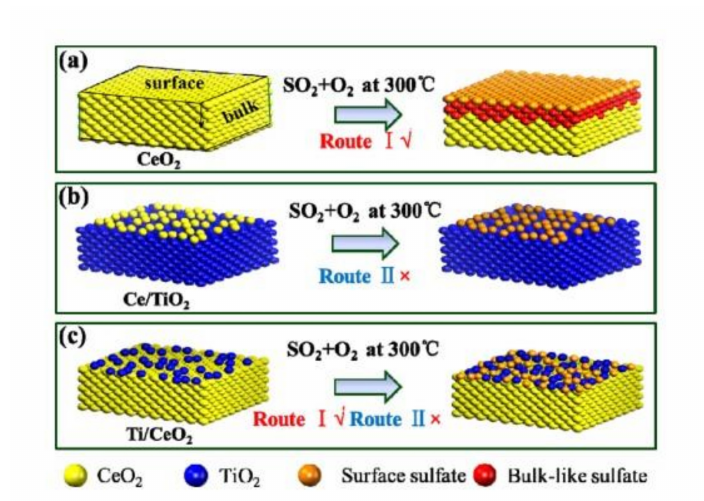
Figure 11. Sulfur resistance mechanism of ( a ) CeO 2 , ( b ) Ce / Ti and ( c ) Ti / Ce catalyst [39].